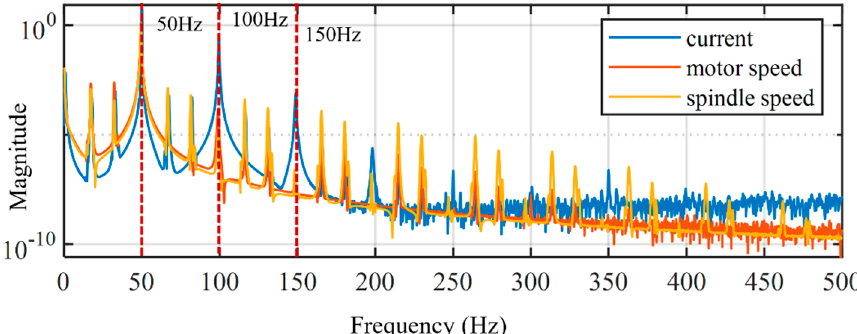
Figure 11. Spectra for current and rotational speeds of the motor and spindle.